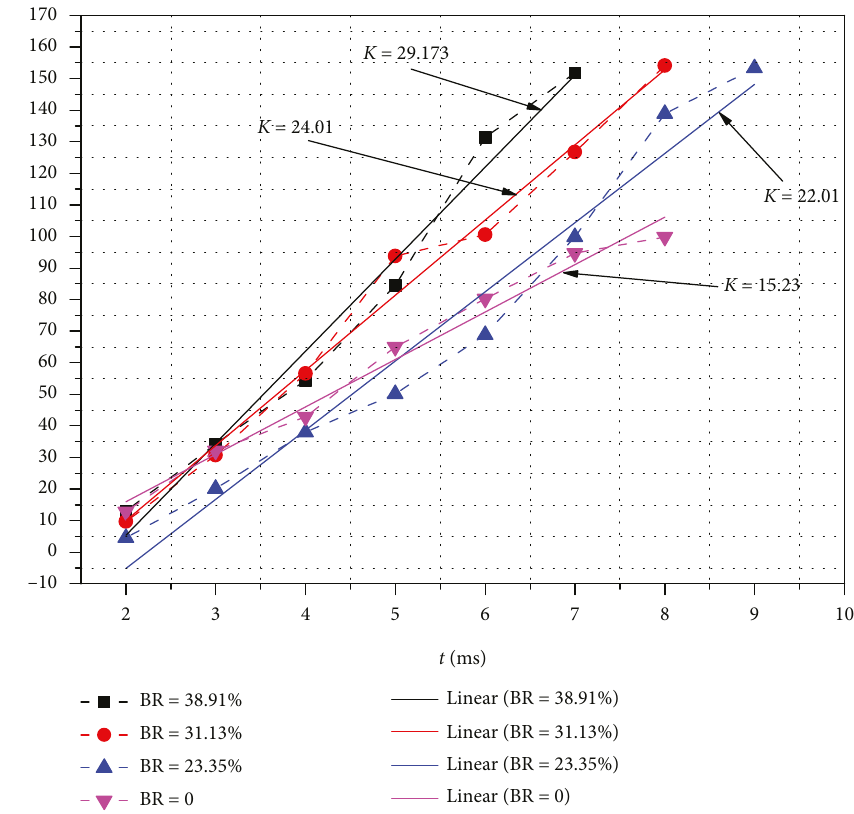
Figure 16: Variation of fl ame front position with time for WRC with di ff erent blockage ratio